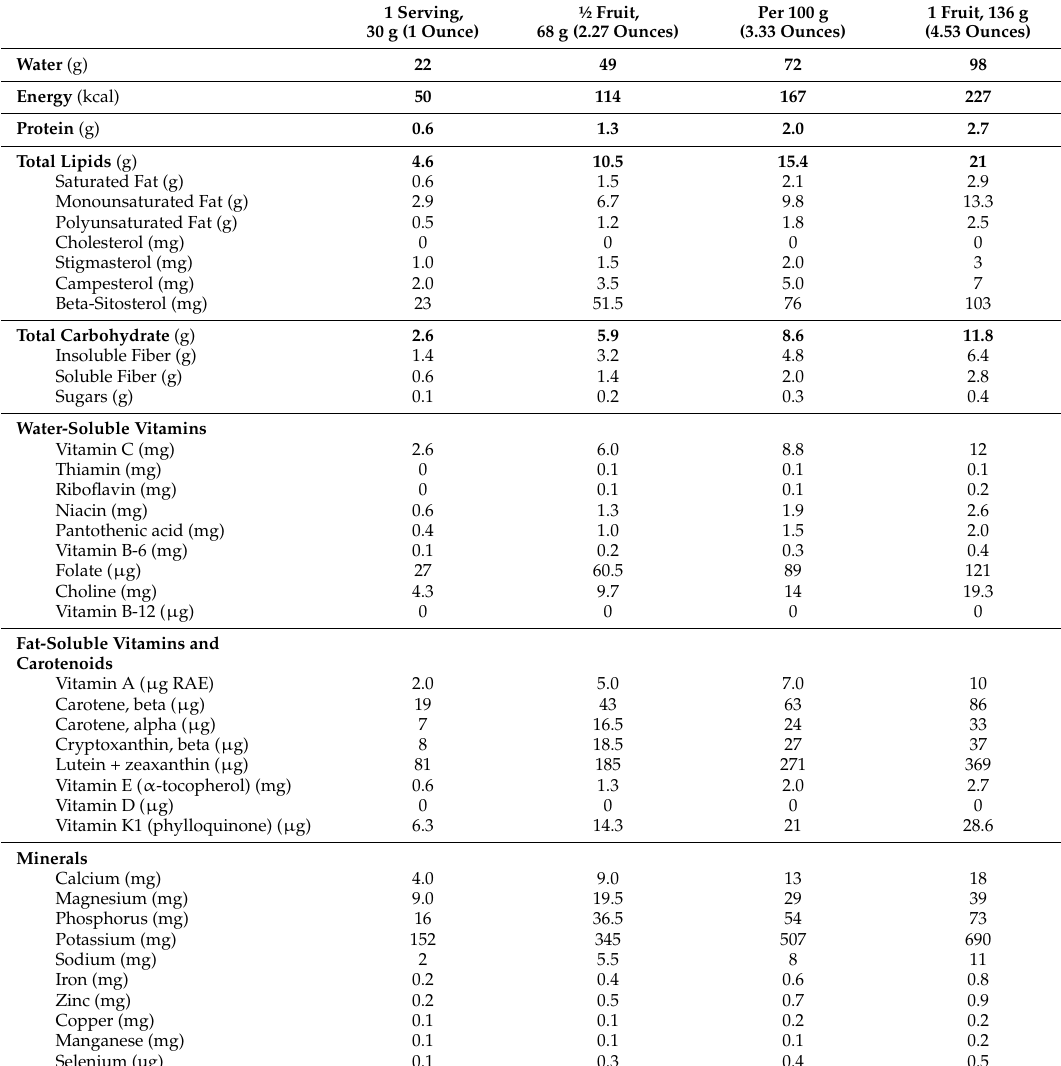
Table 1. California avocado composition (USDA